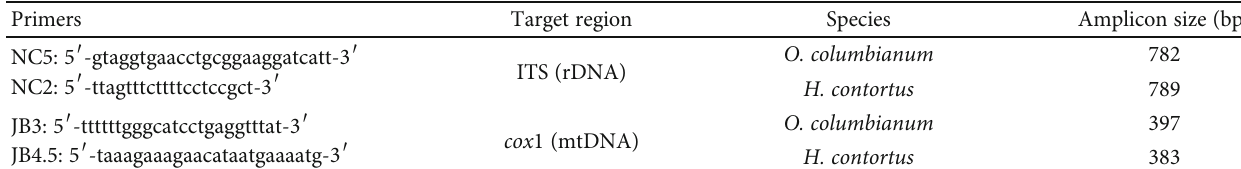
Table 1: Primer sets used, with nucleotide sequence, target region, species, and size of amplicon.